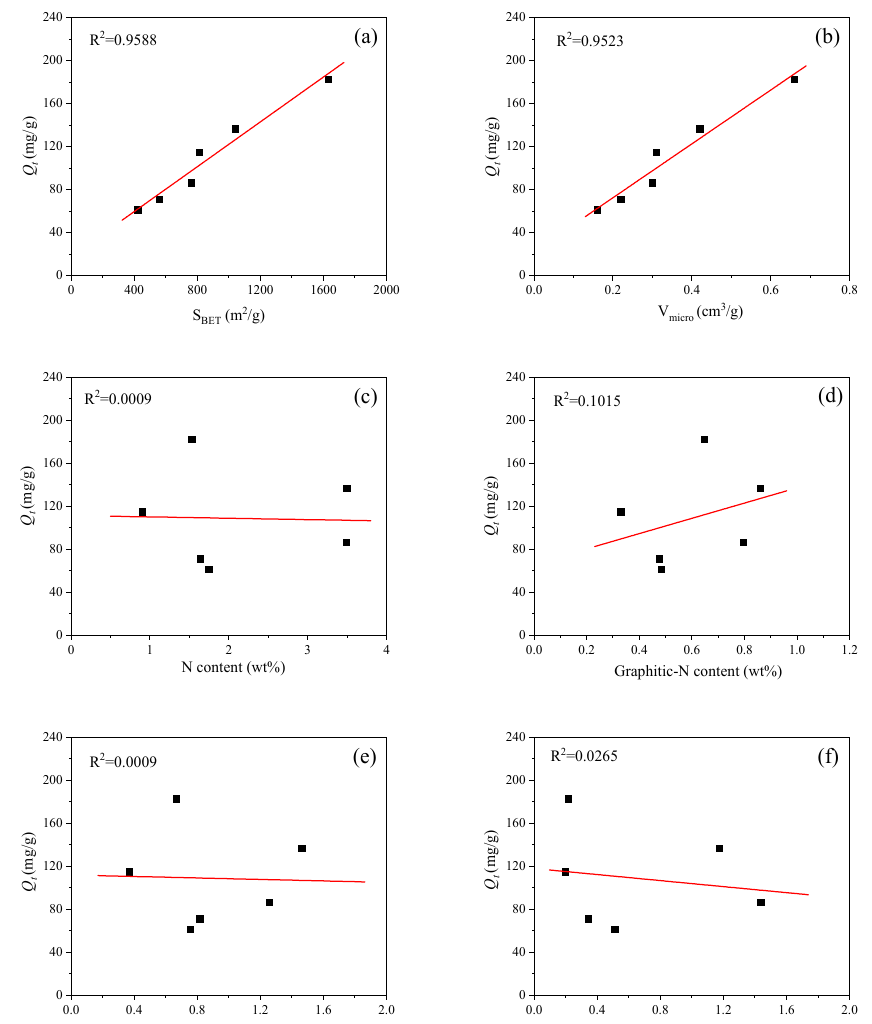
Figure 12. Dependence of phenol adsorption capacity on the specific surface area ( a ), micropore volume ( b ), total N content ( c ), graphitic-N content ( d ), pyrrolic-N content ( e ), and pyridinic-N content ( f ) of the lignite-based porous carbons. Adsorption conditions: C 0 = 133 mg/L, m / v = 0.4 g/L, 20 °C, t = 90 min.